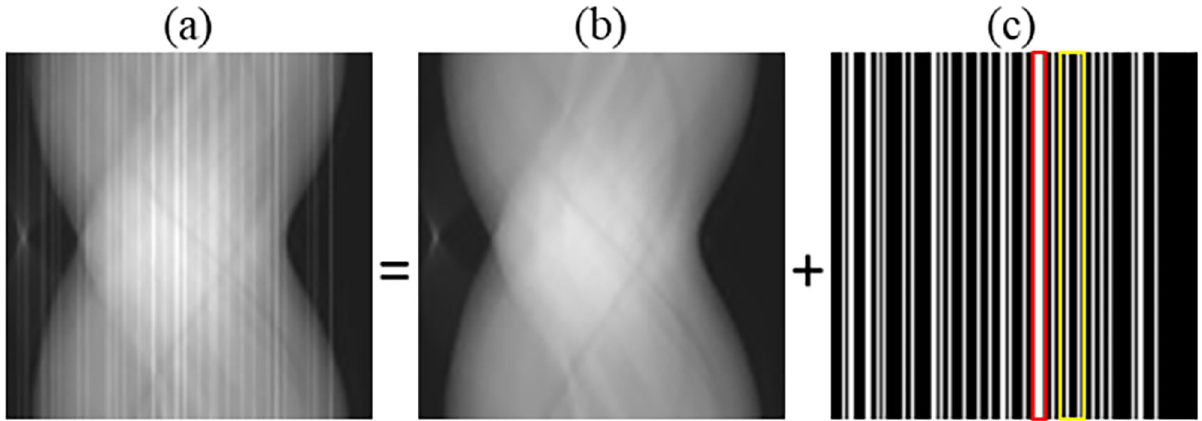
Fig 1. Projection data with vertical artifacts caused by bin failures in (a) can be modeled as a combination of (b) ideal projection data and (c) ring artifact in the projection data domain. Red and yellow rectangles in (c) demonstrate the adjacent and non-adjacent bins failure cases, respectively.